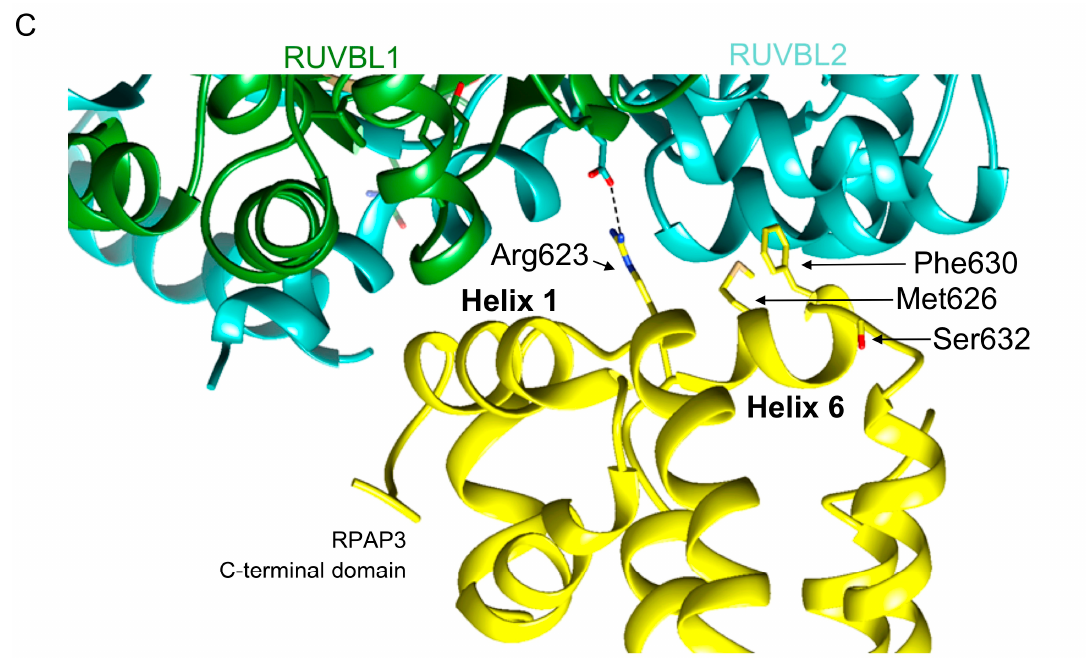
Figure 4. Structure of the RPAP3 C-terminal domain . ( A ) One view of the structure of the RPAP3 C-terminal domain obtained using cryo-EM [36] . The structure shows the interaction with the RUVBL1-RUVBL2 complex. The experimental cryo-EM map is represented as a transparent density. ( B ) NMR coordinates of the RPAP3 C-terminal domain [26] . ( C ) Close-up of the region of contact between the RPAP3 C-terminal domain and RUVBL2 observed by cryo-EM [36] , indicating the residues mutated by Maurizy and colleagues [26] .